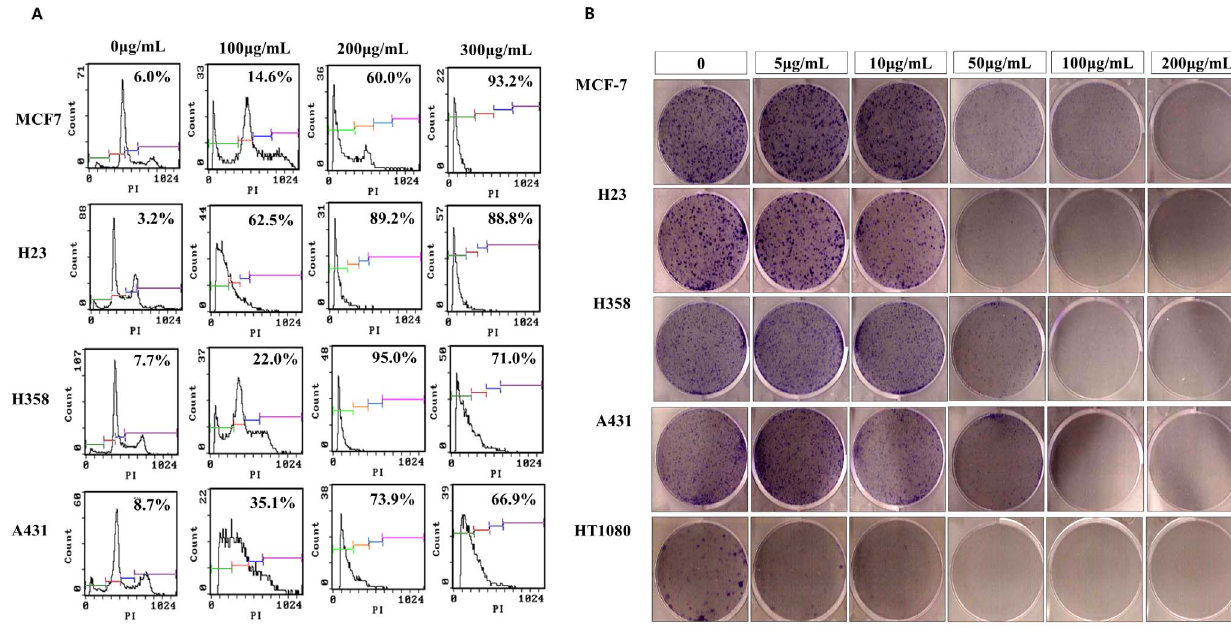
Figure 10. FACS analysis and Inhibitory effect of MOL treatment on the proliferation of different cancer cells. Induction of apoptosis (A) and Colony-formation ability (B) by the MOL extract in different cancer cells was analyzed by FACS and by cologenic assay.